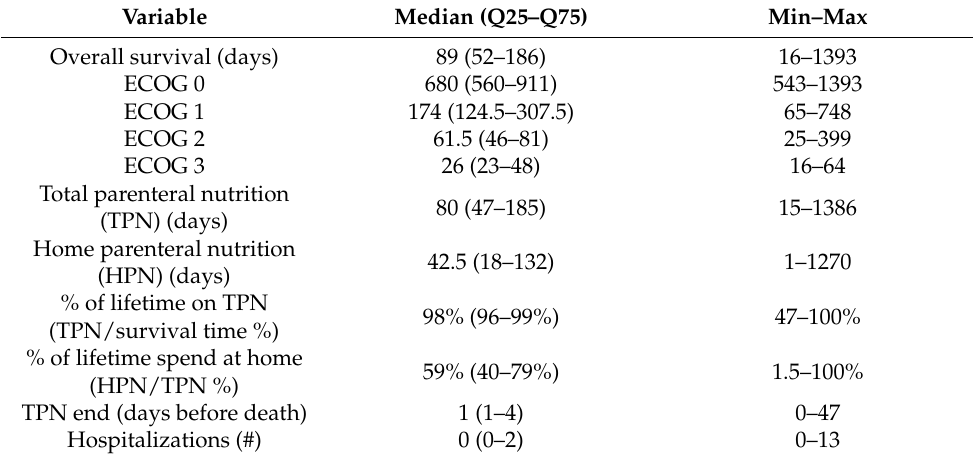
Table 2. Survival time and total parenteral